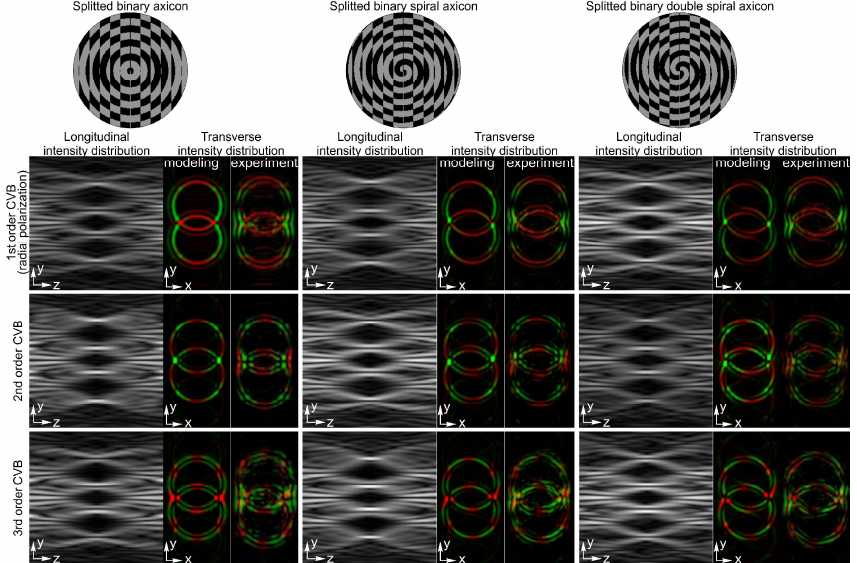
Figure 9. Generation of polarization controlled triple vector optical bottles using different split axicons. The red color indicates the x-component of the intensity and the green color indicates the y-component.